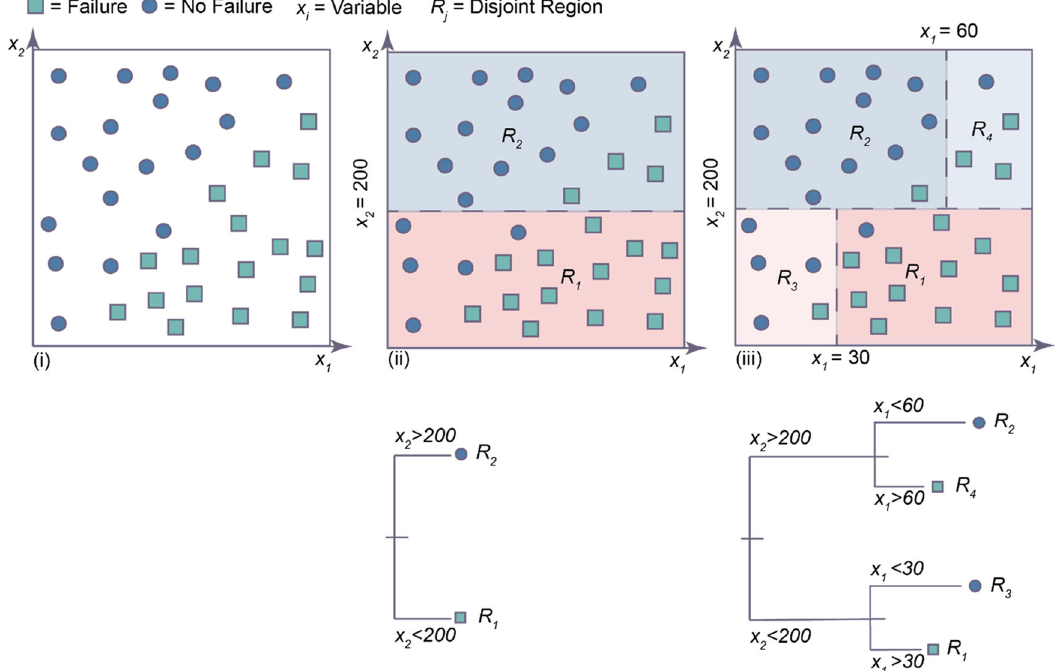
Fig. 5 An example of data partitioning by a classi fi cation decision tree. (i) shows the two-dimensional data space. (ii) fi rst condition for partitioning the data by variable x 2 at 200, where disjoint region R 1 is ≤ 200 and disjoint region R 2 > 200. (iii) second condition for partitioning data by variable x 1 at both 30 and 60 to create two more disjoint region R 3 and R 4 (Taken from Barton et al. 55